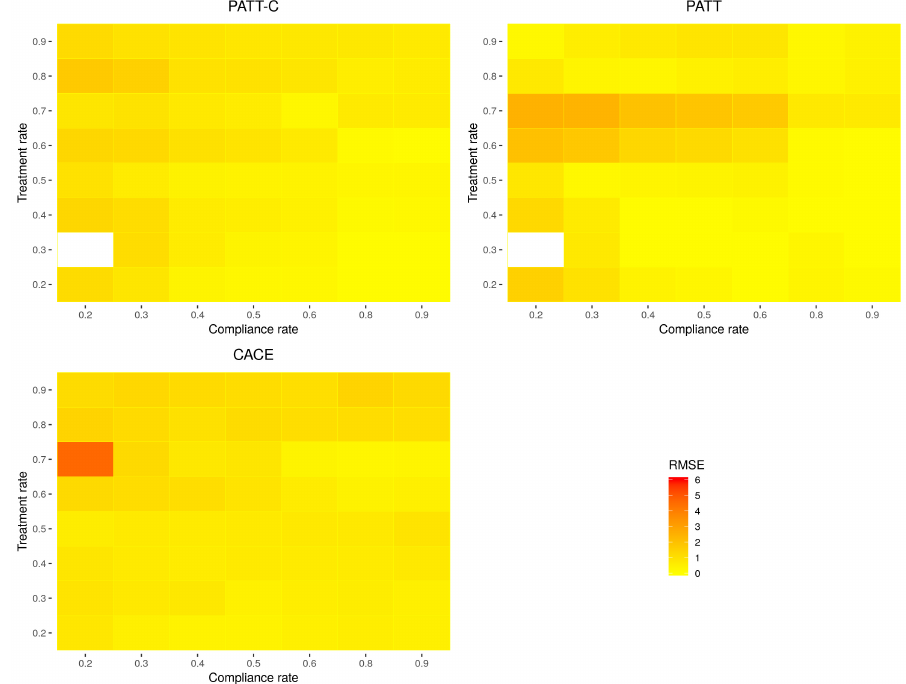
Figure 3: Average RMSE binned by compliance rate and treatment